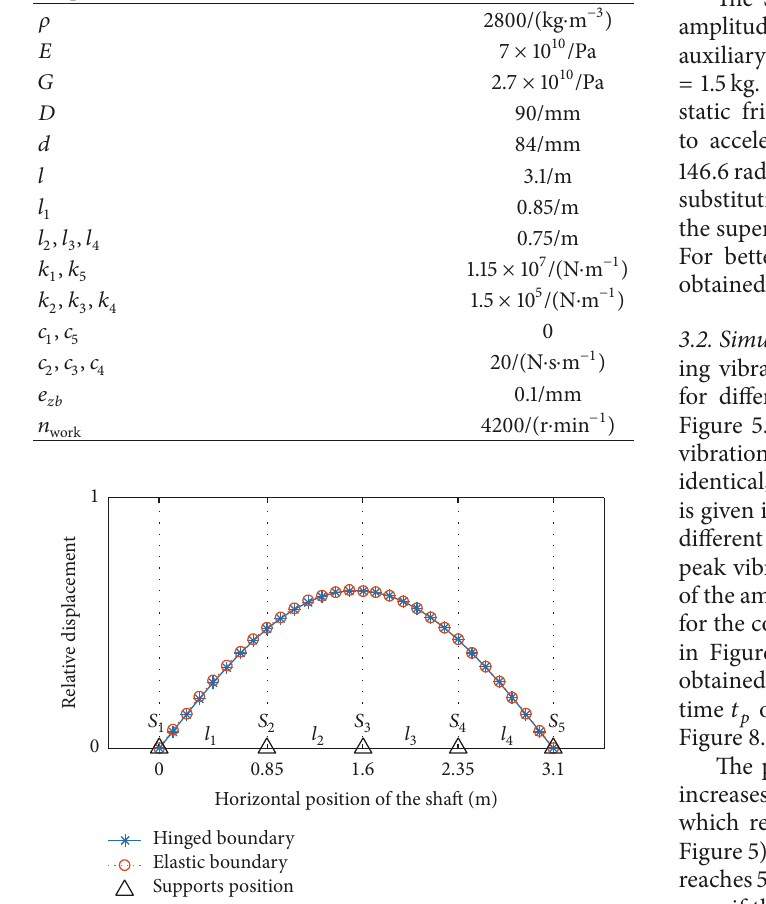
Figure 4: 1st mode shape with hinged and elastic boundaries of the helicopter tail